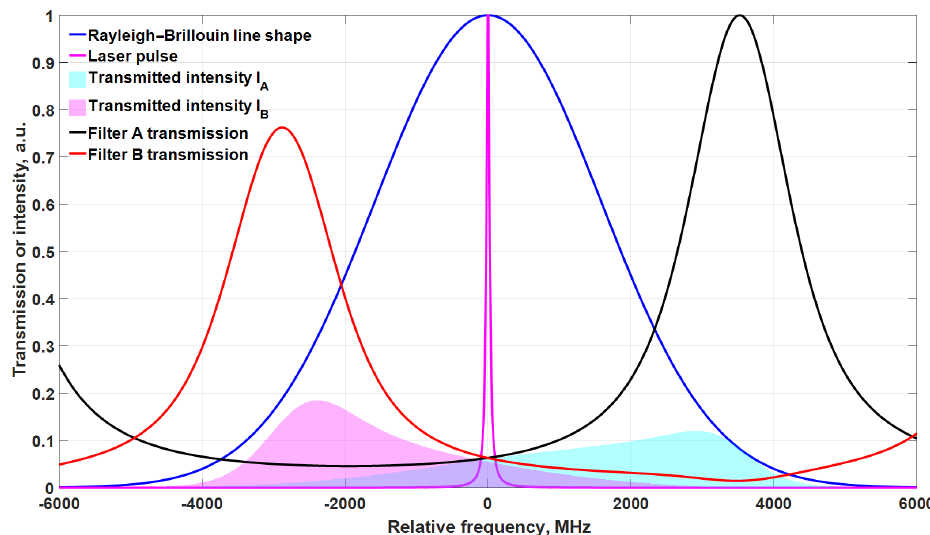
Figure 1. Modeled spectral distribution of the transmitted laser pulse (pink line) and pure molecular backscatter (blue line) for T = 270K and P = 700hPa (normalized to one). The Rayleigh channel transmission spectra of two FPIs are shown by black ( T A ( f ) ) and red ( T B ( f ) ) lines. The transmitted, integrated intensities through FPI A and B are marked with light-blue and magenta filled areas, respectively.